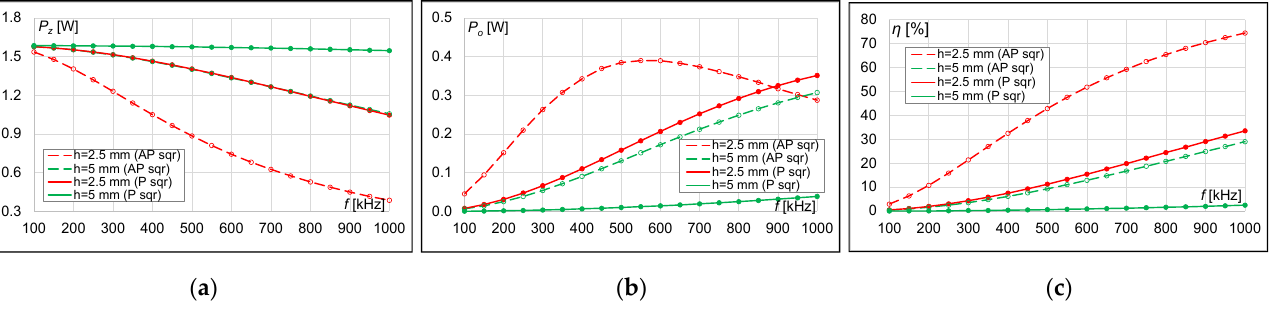
Figure 14. Results for square coils with r = 5 mm and the number of turns n = 25 at two distances ( h = 2.5 mm and h = 5 mm): ( a ) transmitter power, ( b ) receiver power, ( c ) power transfer efficiency. Regardless of the frequency, the efficiency of the system is comparable for two mod- els: periodic at h = 2.5 mm and aperiodic at h = 5 mm (Figures 12c, 13c, and 14c). Regardless of the number of turns, the highest efficiency of the system is for the aperiodic model at h = 2.5 mm, e.g., for the number of turns n = 25, the efficiency of the system is 75% at the frequency f = 1 MHz (Figure 14c). The highest difference in efficiency between aperiodic and periodic models occurs at n = 15 and h = 2.5 mm and reaches 47% (Figure 12c). 3.3.2. Models with a Large Square Coil ( r = 20 mm) Characteristics: transmitter power, receiver power, and efficiency at a distance h = r /2 = 10 mm and h = r = 20 mm for periodic and aperiodic models with large square coils are shown in Figures 15–17.